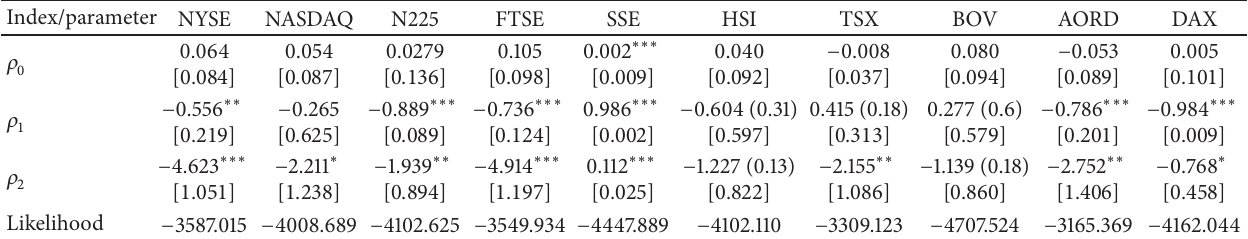
Table 5: Results of TVRA-GARCH-M model ( 𝑃 10 𝑡 ).